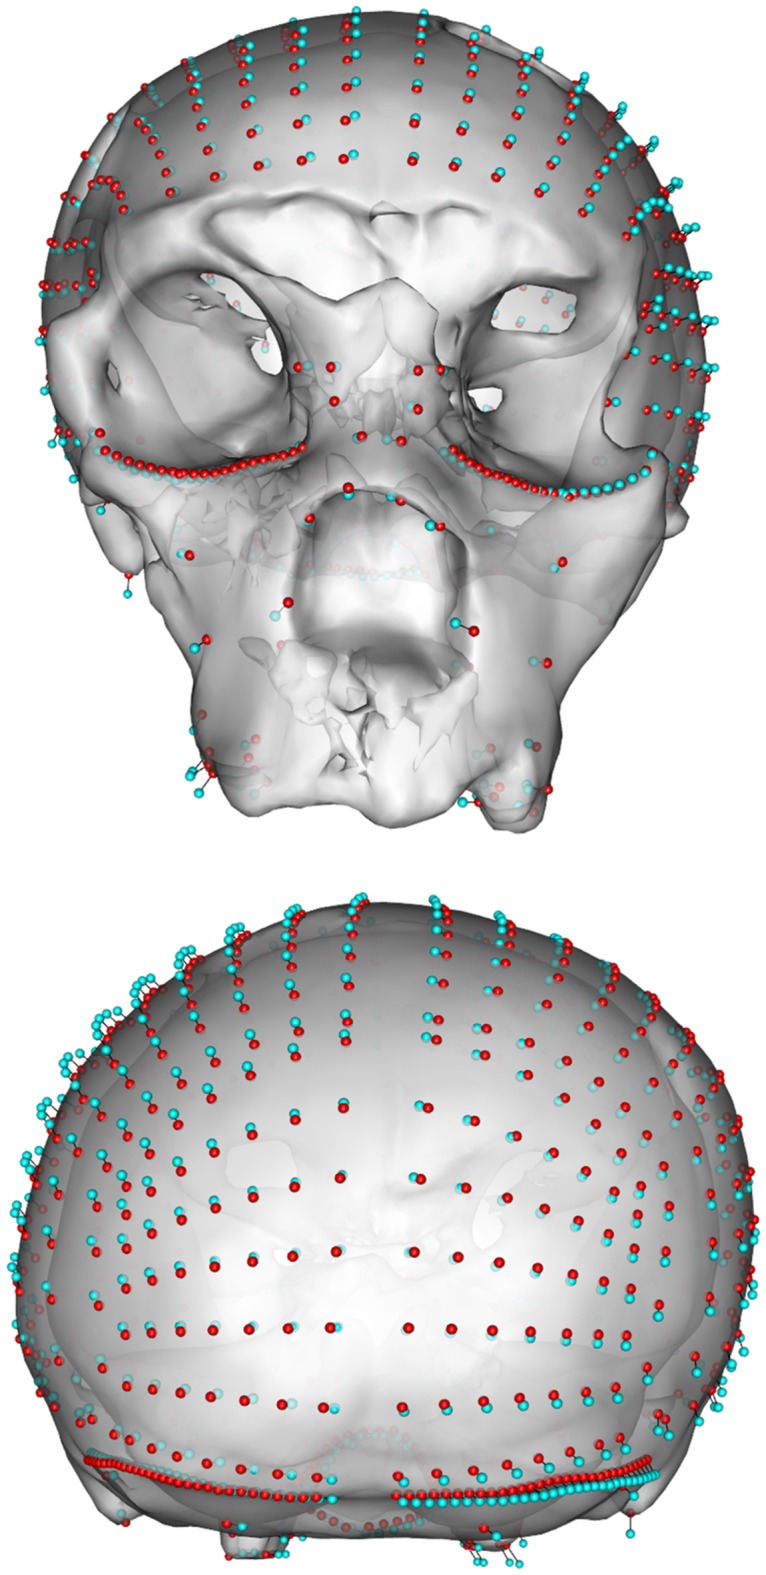
Removal of asymmetric noise in the semi-landmarks.Placement of semi-landmark sets before (cyan) and after sliding (red) on the cranium of SCP1 in frontal and posterior views.